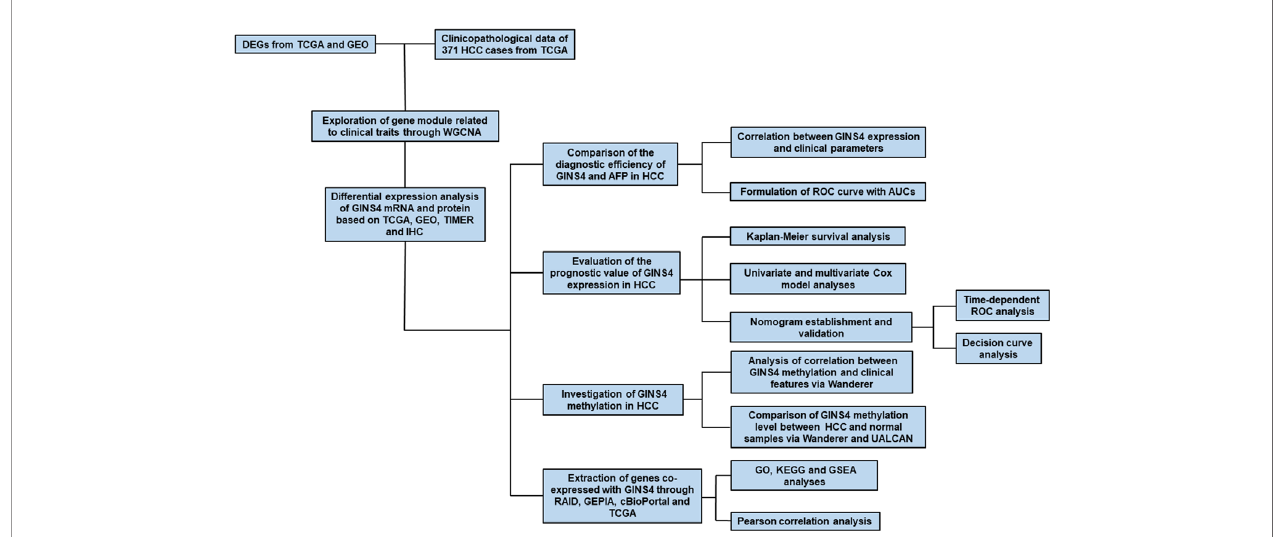
FIGURE 1 | Flow chart of the present study. DEGs, differently expressed genes; WGCNA, weighted gene co-expression network analysis; IHC, immunohistochemistry; TIMER, the Tumor Immune Estimation Resource database; AUC, the area under the curve; ROC, the receiver operating characteristic; DCA, Decision curve analysis; GEPIA, Gene Expression Pro fi ling Interactive